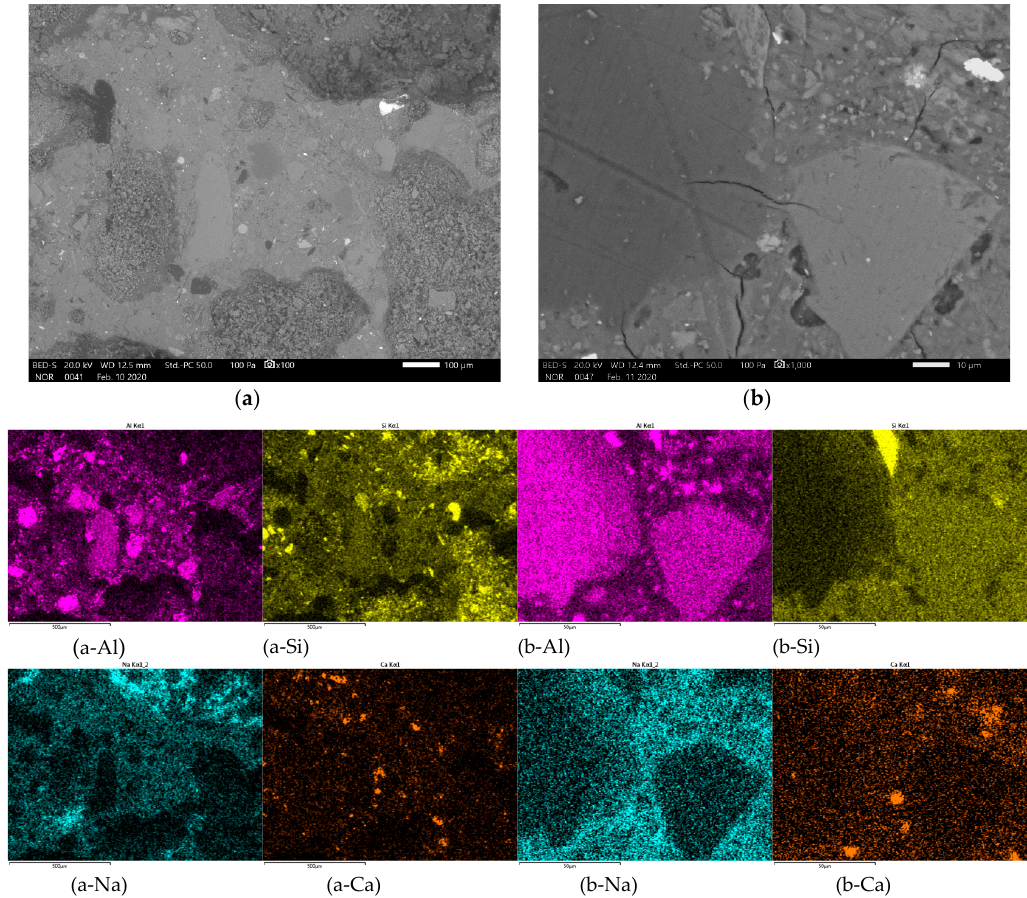
Figure 9. SEM micrograph of alkali activated material prepared from precursor’s fraction 1 mm < x ≤ 2 mm with magnification of ( a ) 100 and ( b ) 1000. EDXS mapping is presented in (b - chemical element) of area (b).